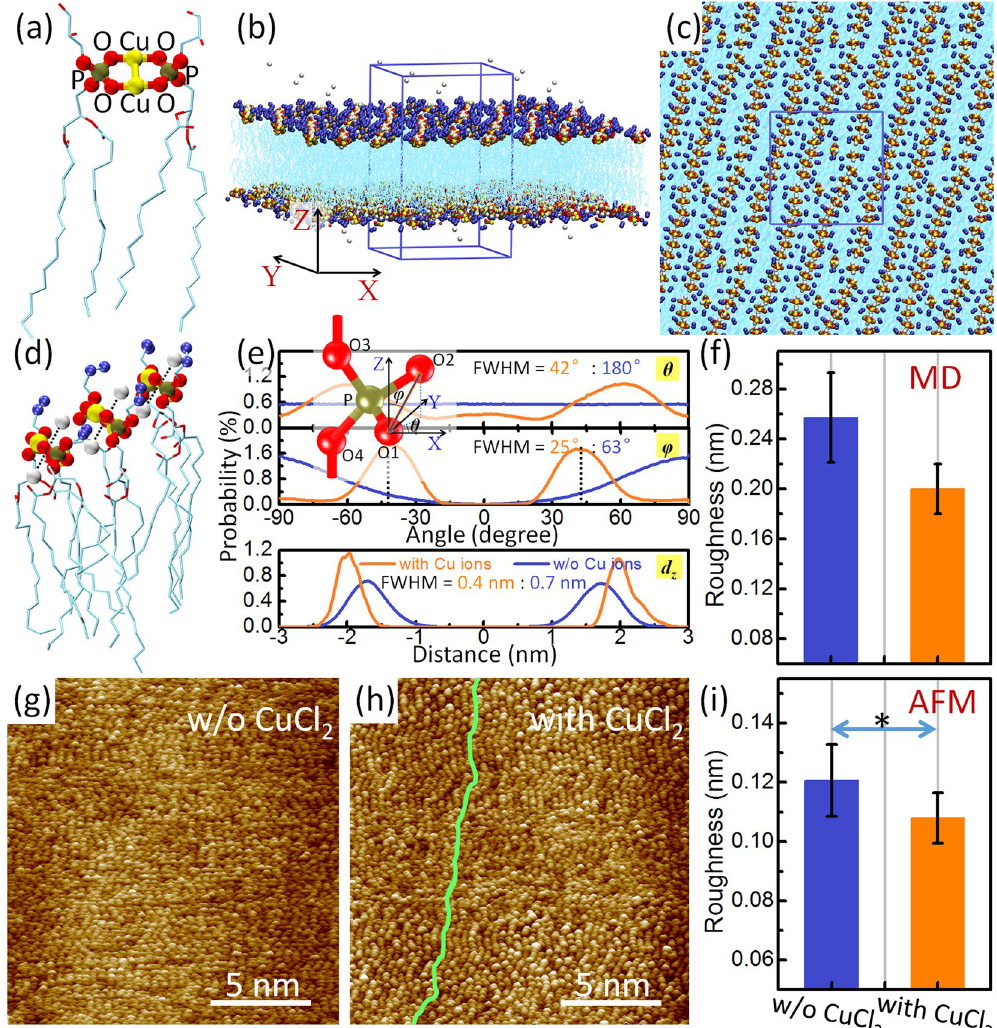
Figure 5. Assembly and order-analyses of phospholipids in membranes caused by Cu ions. ( a – f ) Lipid assembly induced by PL- di Cu-PL structure through MD simulations. The light blue, brown, red, yellow and silver balls represent carbon, phosphorus, oxygen, copper and chlorine, respectively. For clarity, hydrogen atoms and water molecules are not shown. ( a ) Applied PL- di Cu-PL structure in the PG-bilayer simulations. ( b , c ) Typical conformation of assembled lipids in membrane with side ( b ) and top ( c ) views. The blue box represents the periodic boundaries applied in the simulations. The tails of lipids and the atoms in the terminal of the lipid heads are represented by light blue curves and blue balls, respectively, for clarity. ( d ) A segment of assembled lipids. Two Cl − ions (silver balls) are observed over and under (dotted lines) the Cu-O plane, respectively. ( e , f ) Analyses of PL- di Cu-PL induced assembly based on the degrees of order ( e ) and roughness ( f ). ( e ) The upper- left inset shows the applied angles ( θ , ϕ ) for the order degree in x-y plane. Upper and middle: Distributions of lipids according to the angles θ and ϕ , respectively. The black dotted lines denote the locations ± 42.5° of two peaks. Lower: Distribution of phosphorus atoms in lipids along the z direction ( d z ), where the coordinate origin is set at the midpoint of two layers. The full-width half-maximum (FWHM) is presented for peaks in presence (orange value) and absence (blue value) of Cu ions. ( g – i ) AFM measurements. AFM images without ( g ) and with ( f ) incubation of CuCl 2 , and a comparison of the roughness of membrane surfaces ( i ). ( h ) The light green curve represents a stripe clearly in the membrane. ( i ) The label * over double-arrow line indicates the P value < 0.05 of significant difference between the two groups of data. This suggests a significant difference in roughness of the membranes with and without CuCl 2